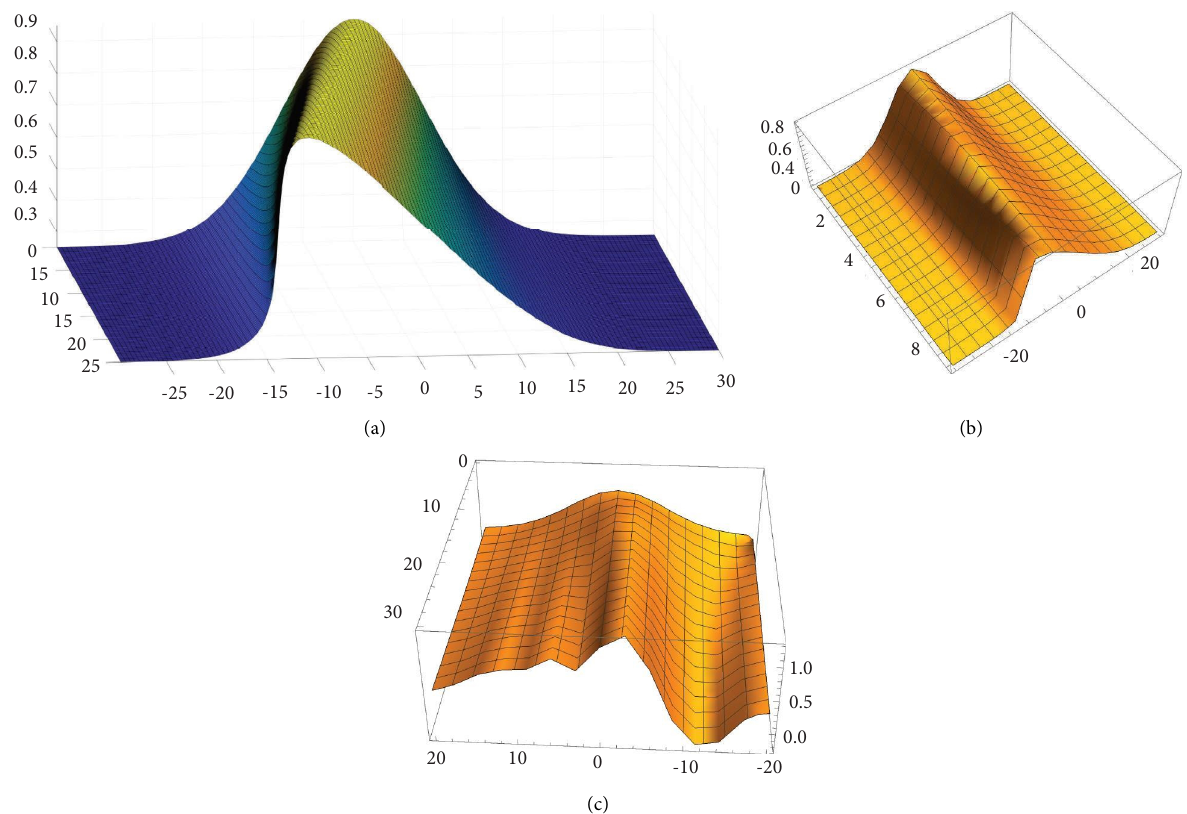
Figure 3: A comparison of the solution of equation of Example 1 using the present method: (a) with solution by Mathematica Software and (b) solution by the method of reproduction